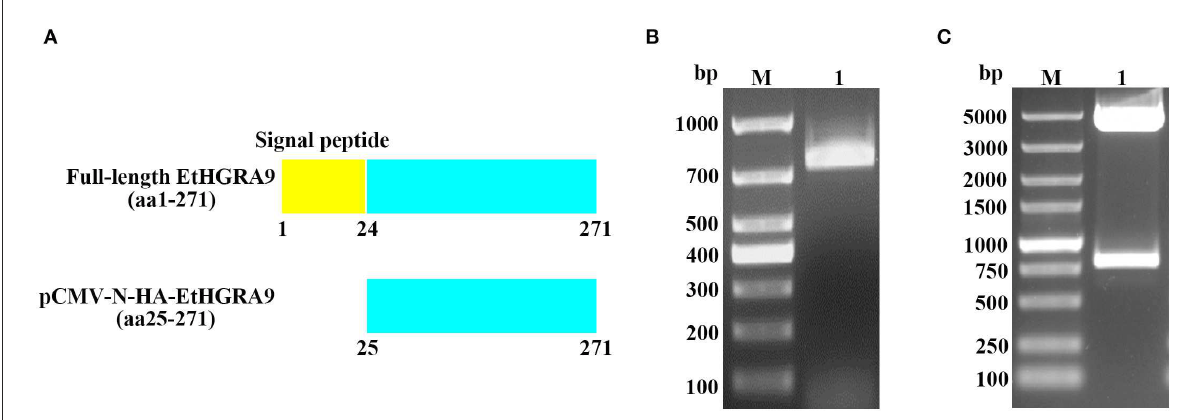
FIGURE1 Construction of the pCMV-N-HA-EtHGRA9 expression vector. (A) The full-length EtHGRA9 protein and the region used for construction of the recombinant plasmid. (B) The EtHGRA9 gene segment amplified by PCR. (C) The constructed pCMV-N-HA-EtHGRA9 plasmid was confirmed by restriction enzyme